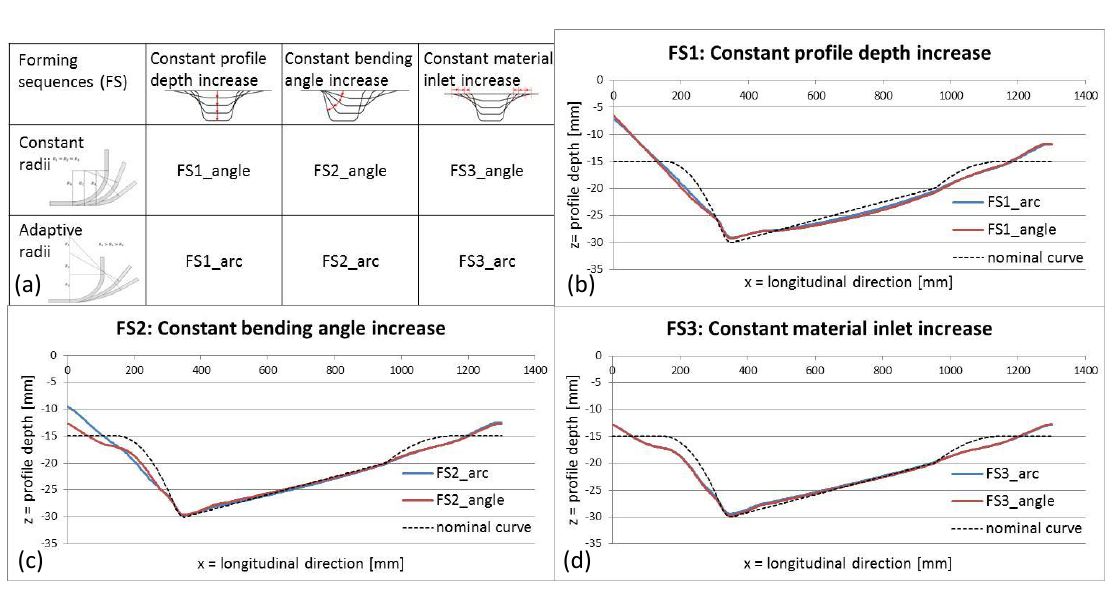
Figure 18. ∆α/(r u + r o ) at each roll pass of the forming sequences. The forming sequences with larger deviations all have a strong increase of ∆α/(r u + r o ) in the last the roll passes in common. Additionally, a large quotient in the first roll passes (FS3_angle) appears to have no negative effect on the geometric accuracy. Derived from the results, it can be noted that large increases of ∆α/(r u + r o ) in the last roll passes are to be avoided. Compared to constant bending radii, the application of adaptive bending radii leads to an undesired reduction of ∆α/(r u + r o ) in the